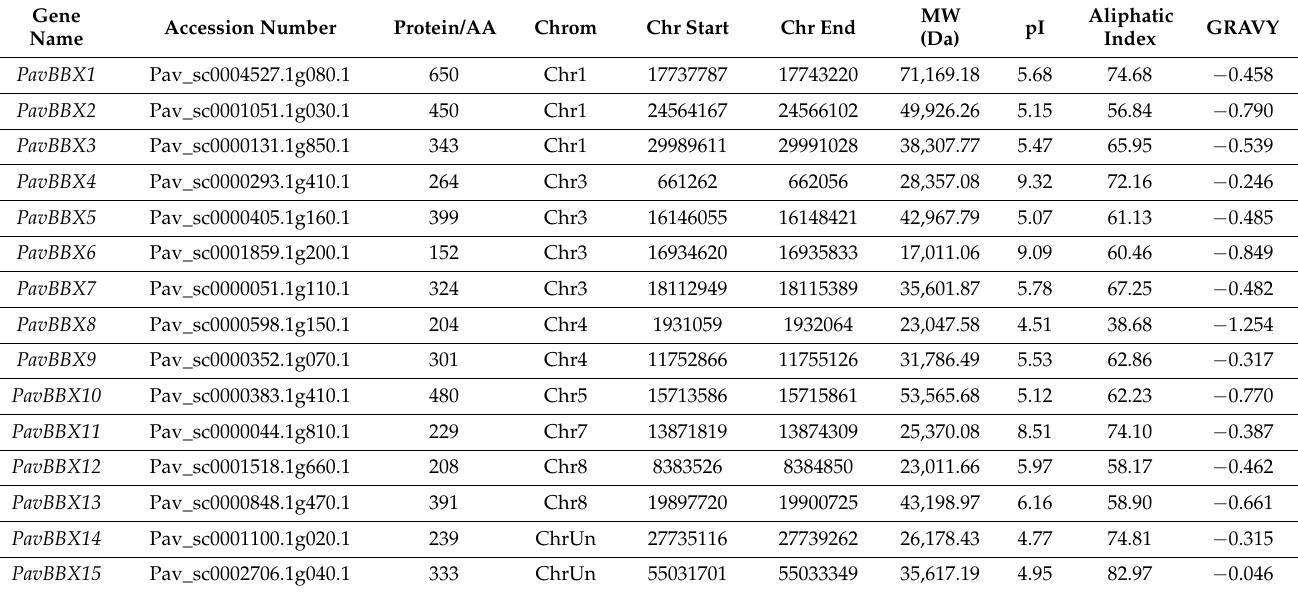
Table 1. BBX family genes in Prunus avium .